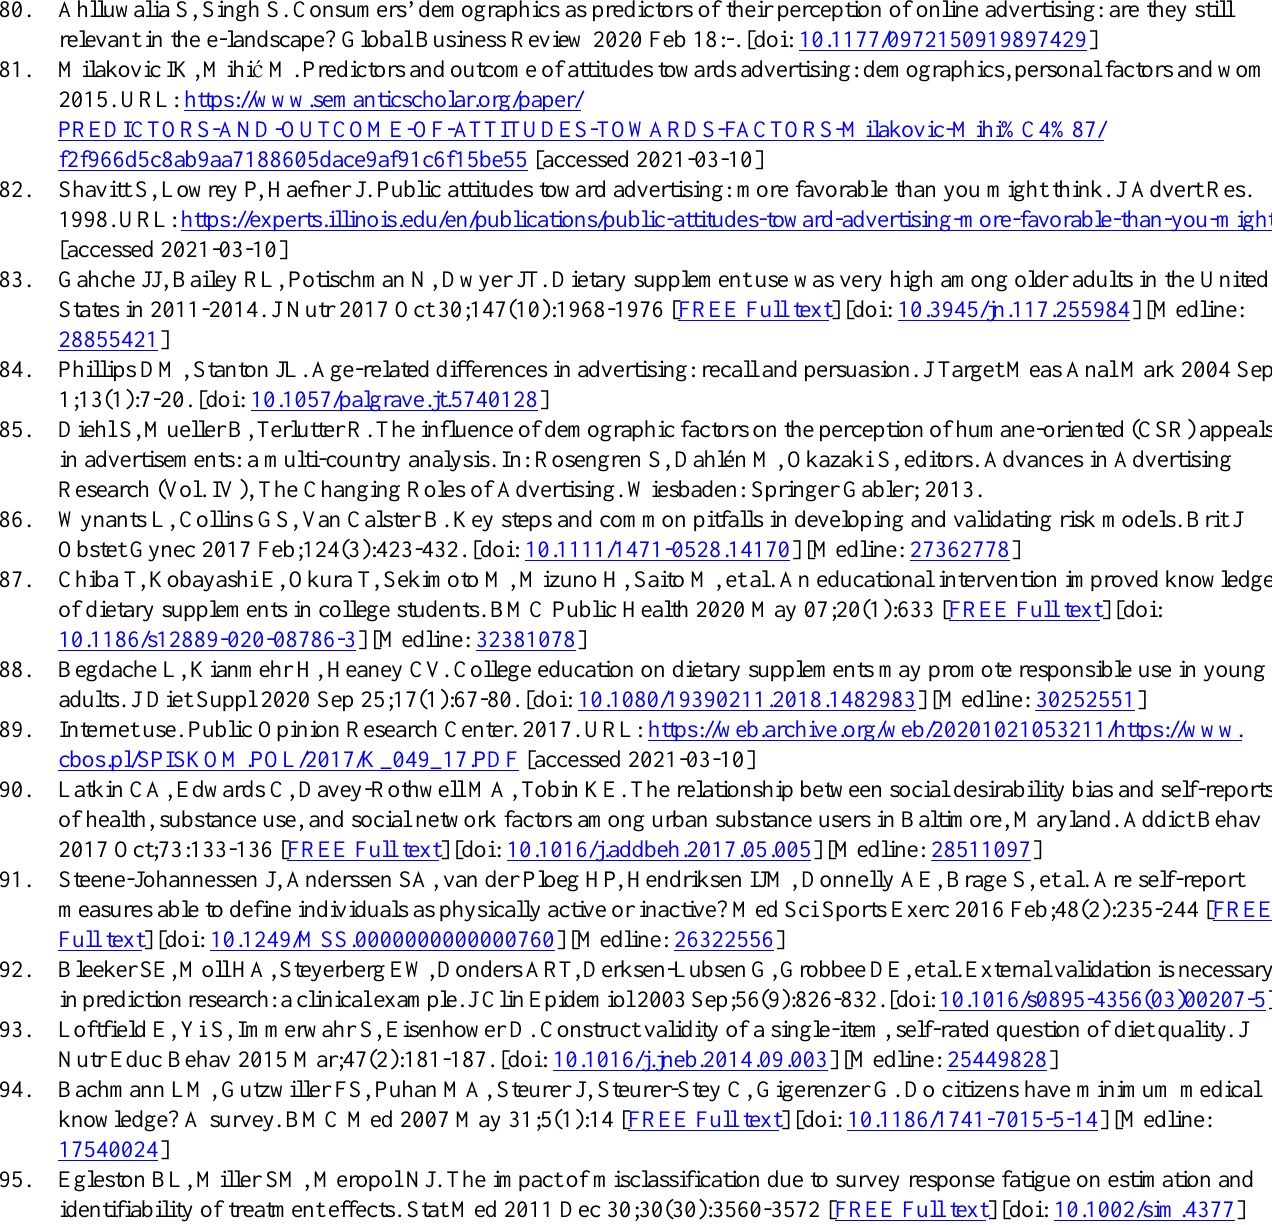
BMQ: beliefs about medicines questionnaire